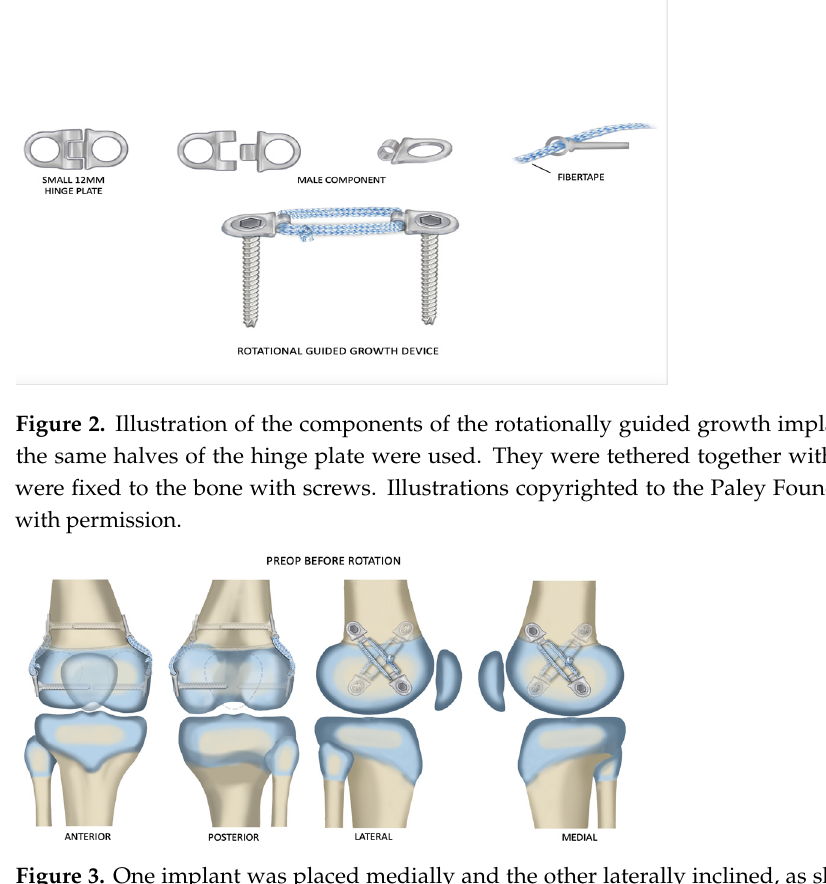
Figure 4. Anterior, posterior, lateral, and medial views of correction before and after rotationally guided growth correction. lllustrations copyright to Paley Foundation; reprinted with permission